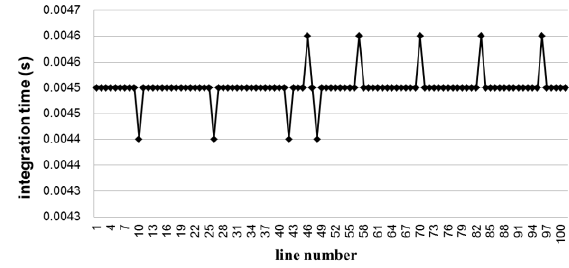
Figure 5. Enlarged view of the red rectangle in Figure 4 Similarly, the row integration time of HRSC cameras also change with the variation of orbiter height. Figure 6 and Figure 7 are row integration time of h4235_0001_s12 and h4235_0001_s22, respectively.